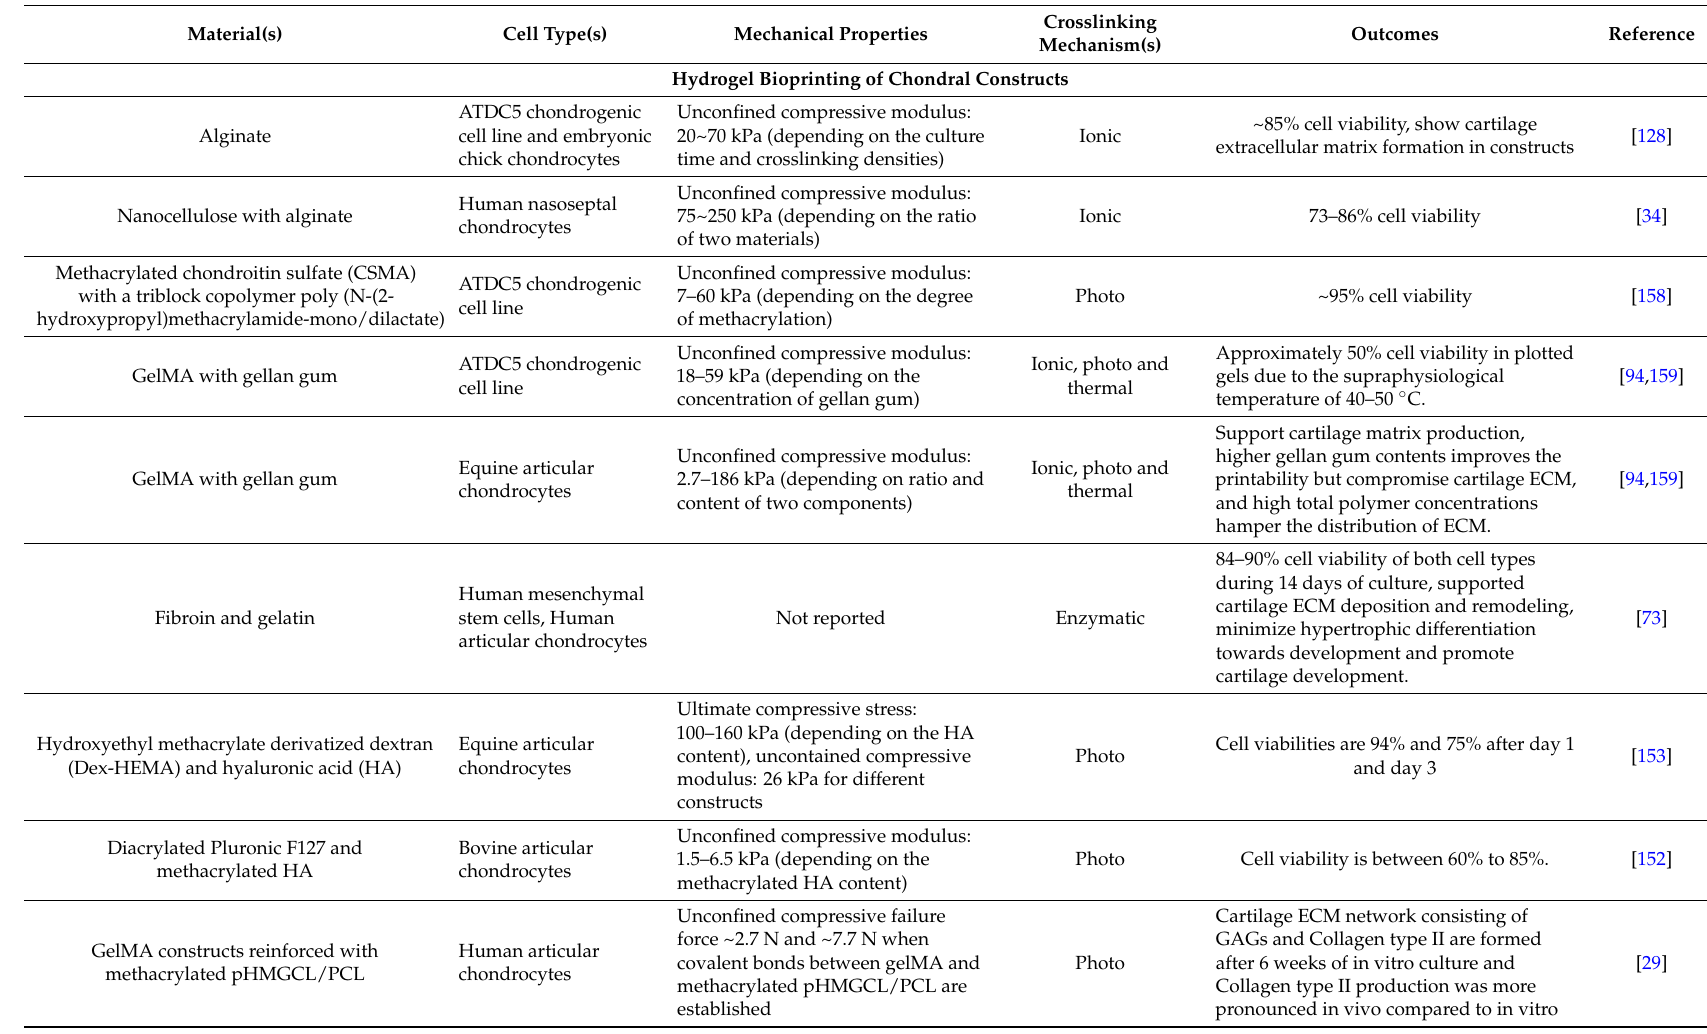
Table 3. Overview of publications on the self-supporting hydrogel bioprinting of (osteo) chondral and zonally organized cartilage regenerative